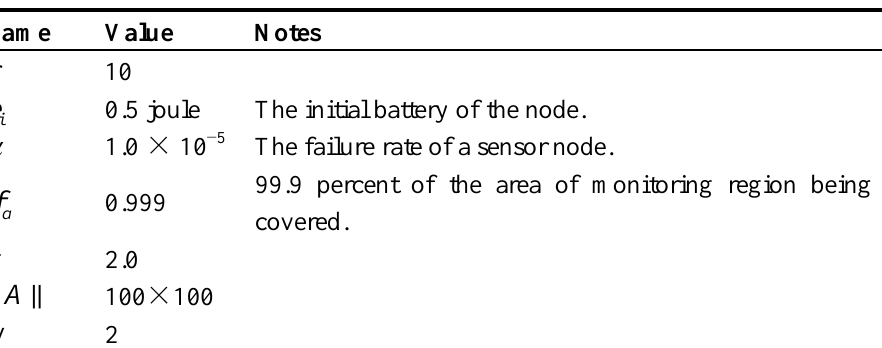
Table 2. The simulation